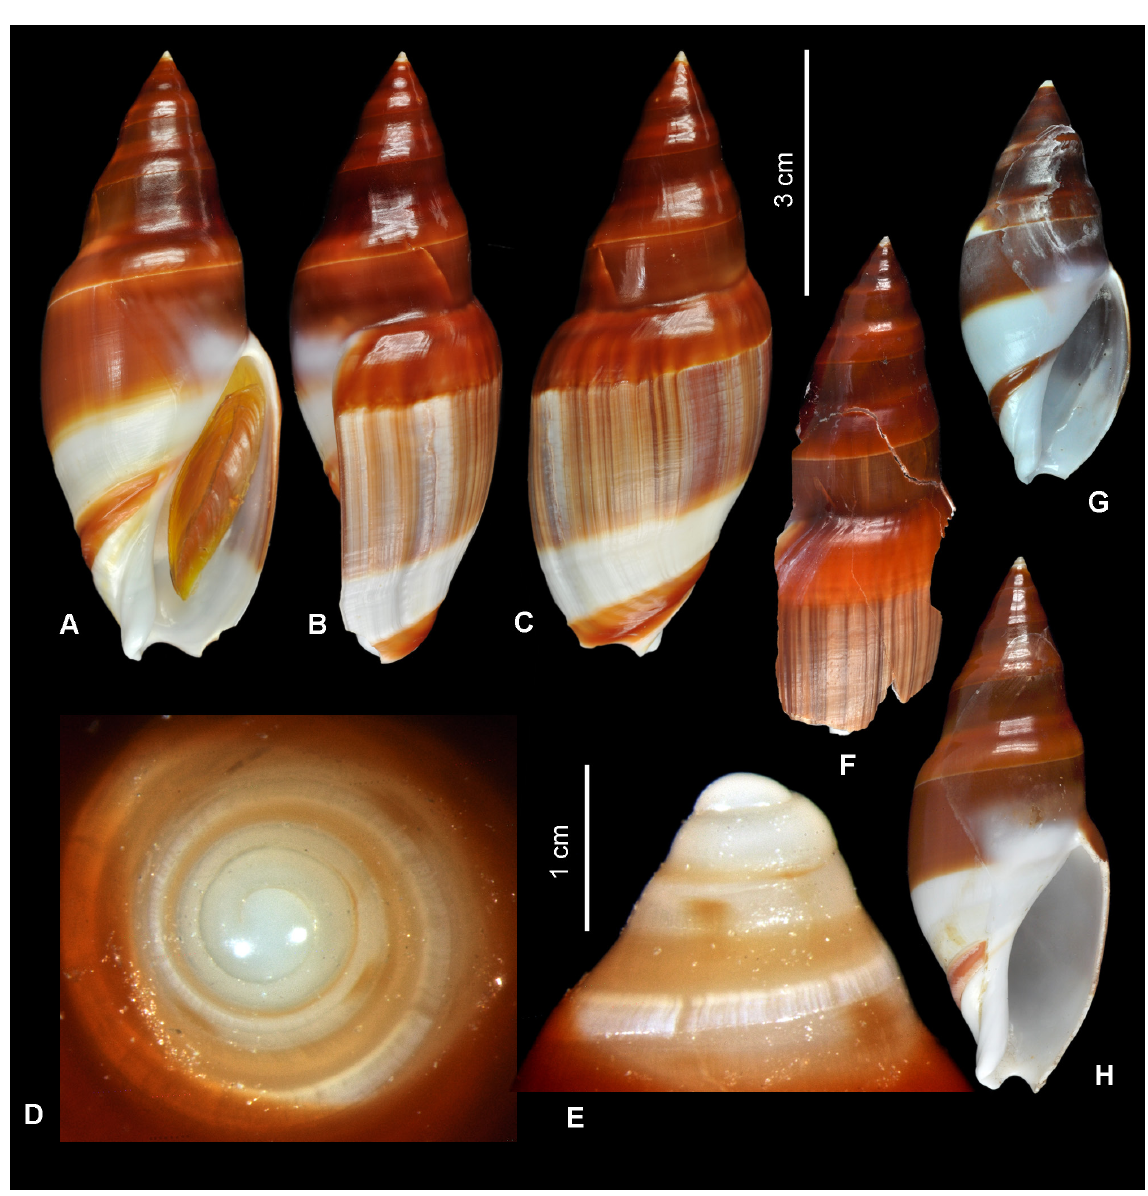
Fig. 11. Amalda cacao sp. nov. A–E . Holotype, MNHN IM-2000-35296, SL 74.9 mm (D–E = enlarged apical and lateral views of the protoconch), specimen not sequenced. F . MNHN IM-2007-33287, SL 61 mm, sequenced specimen. G . KANADEEP 1, stn DW4951, 25°29′ S, 159°49′ E, 310–320 m, Capel Bank, SL 50 mm, specimen not sequenced. H . NORFOLK 1, stn CP1676, 24°44′ S, 168°09′ E, 227–232 m, Norfolk Ridge, SL 67.1 mm, specimen not sequenced. Shells at the same